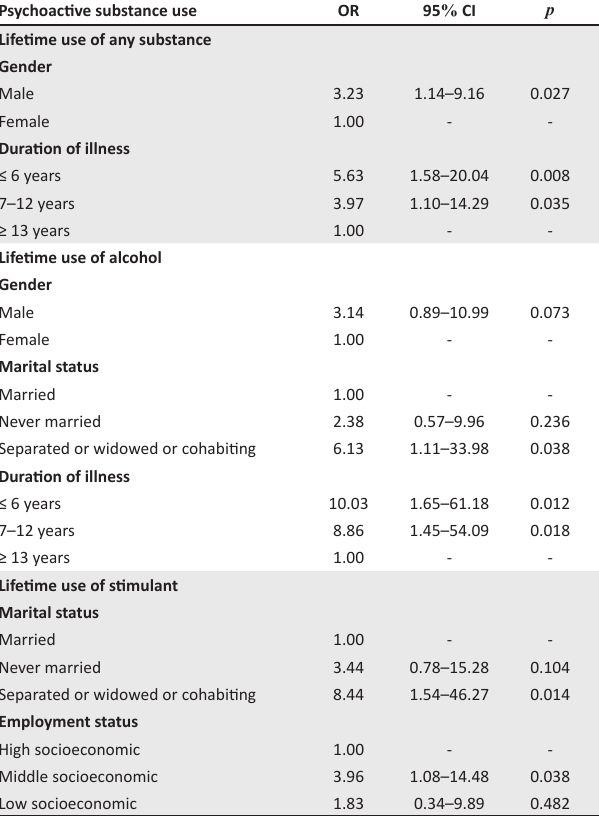
TABLE 3: Multivariate regression analysis showing independent correlates of psychoactive substance use among patients with bipolar affective disorder. Psychoactive substance use OR 95 % CI